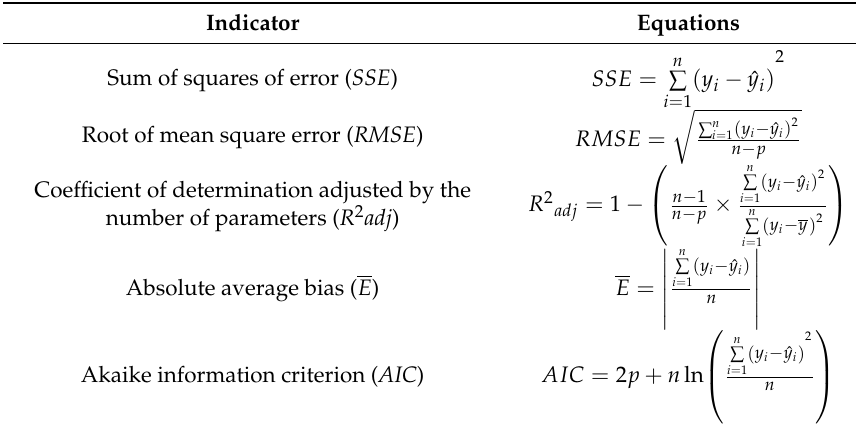
Table 2. Statistical indicators used to evaluate the goodness of fit of the growth and yield equations. Indicator Equations Sum of squares of error ( SSE )